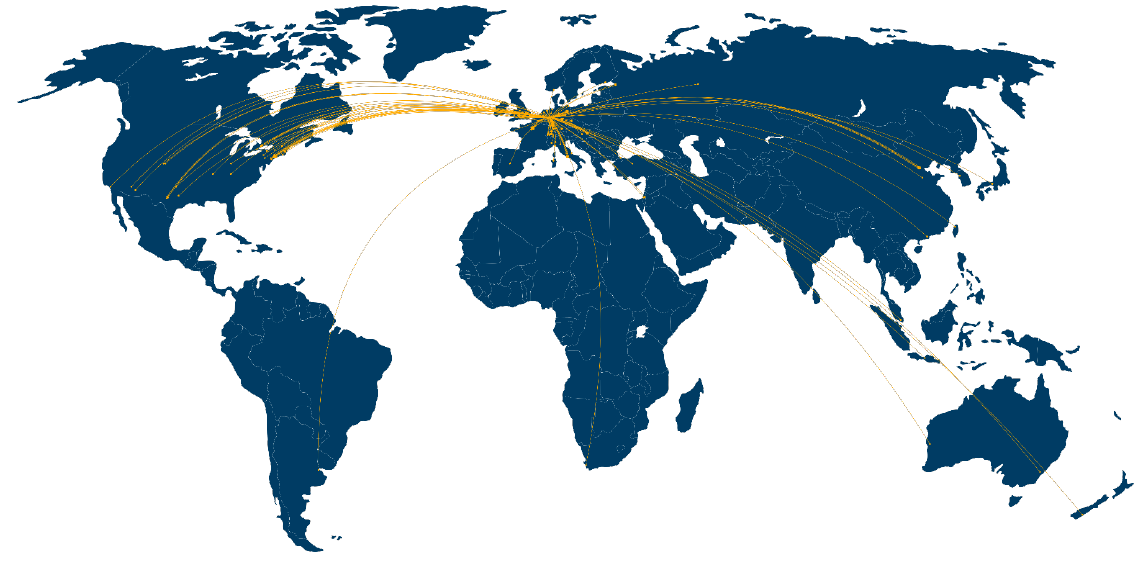
Figure 2 Location of the research fellows’ home